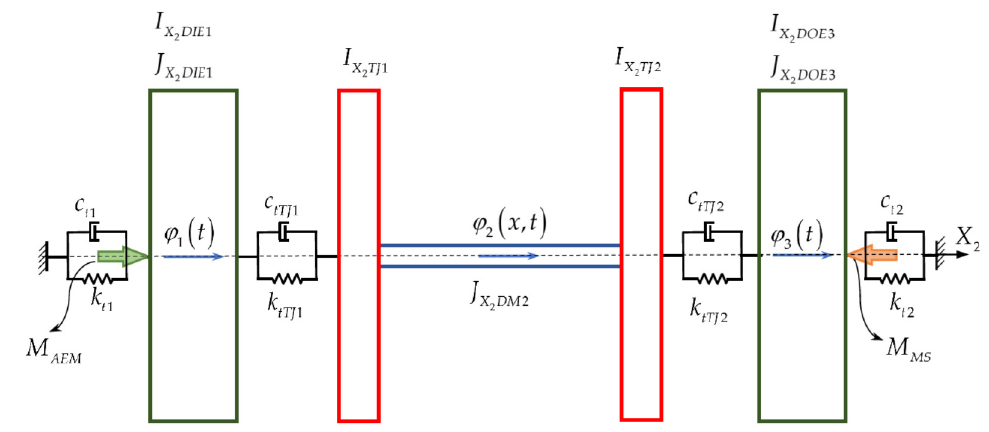
Figure 8. The MPCM of FTV for DTID.